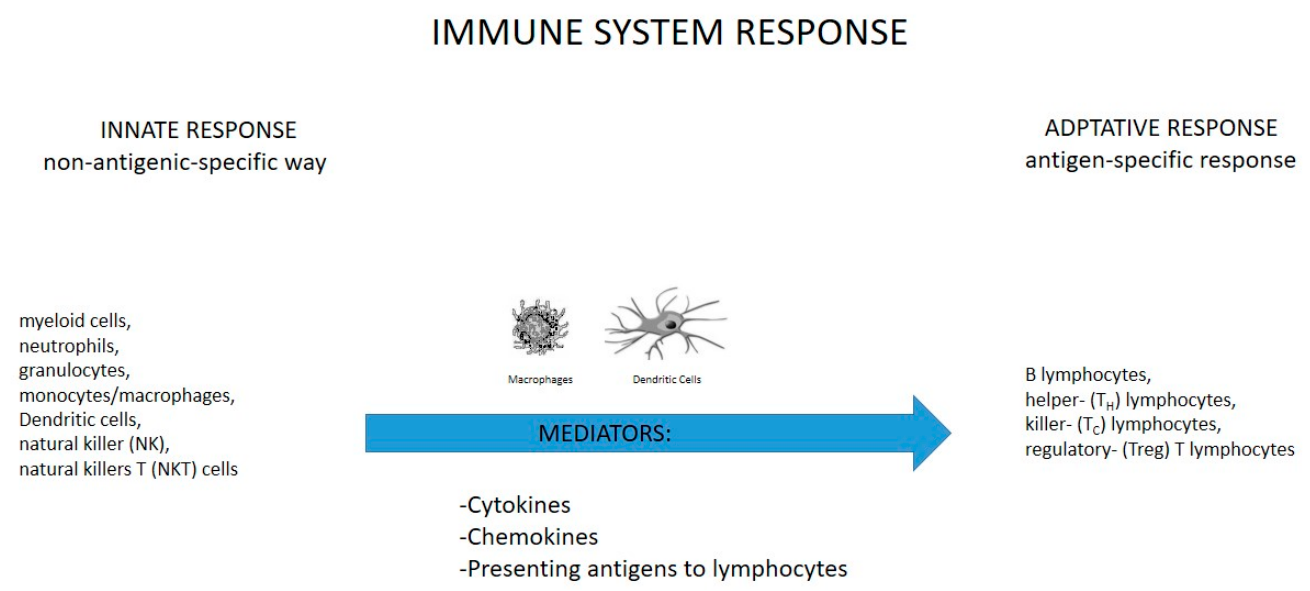
Figure 2. Graphical summary of immune system